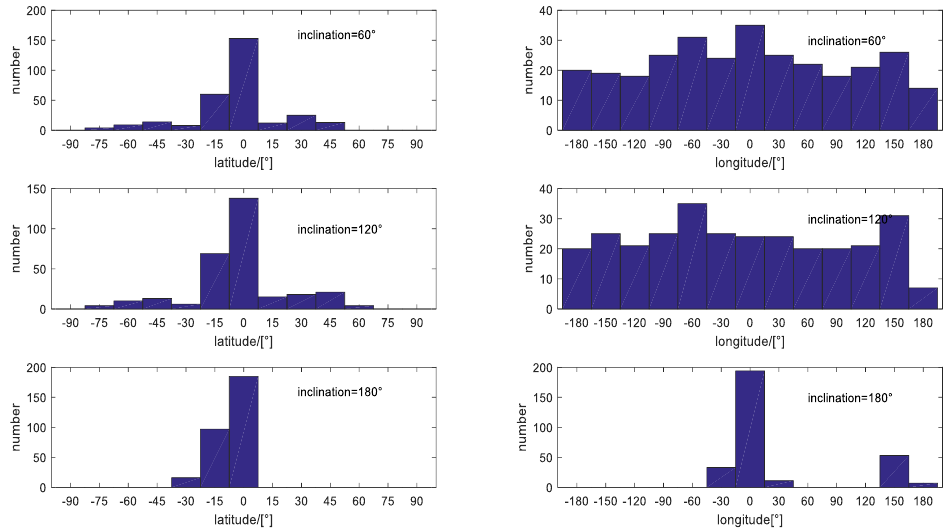
Figure 7. Changes in latitudinal and longitudinal coverage with orbital inclination.